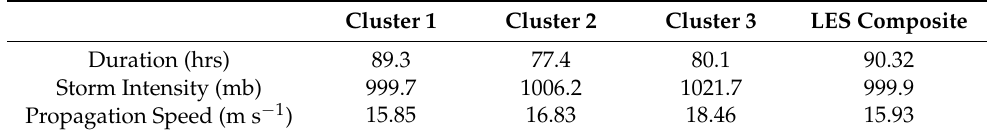
Table 5. Breakdown of average storm characteristics of all clippers by cluster. The storm intensity refers to the MSLP value associated with NARR grid identified as the clipper’s